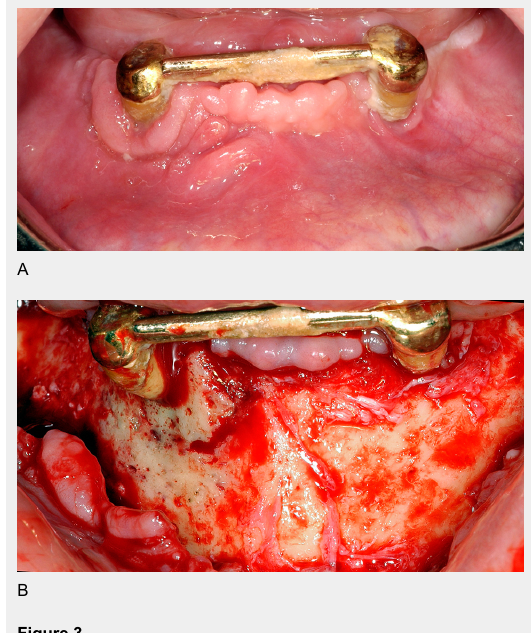
A Female patient with BRONJ of the right anterior mandible associated with periapical infection of the canine. The clinical picture shows no exposed bone, but signs of infection of the surrounding soft tissue and periodontal pus discharge. B The same patient as figure 3A. Intraoperative view shows clearly the necrotic bone area in contrast to the vital bone in the left mandible. The necrotic area is surrounded from granulation tissue. Bone appears green-greyish.